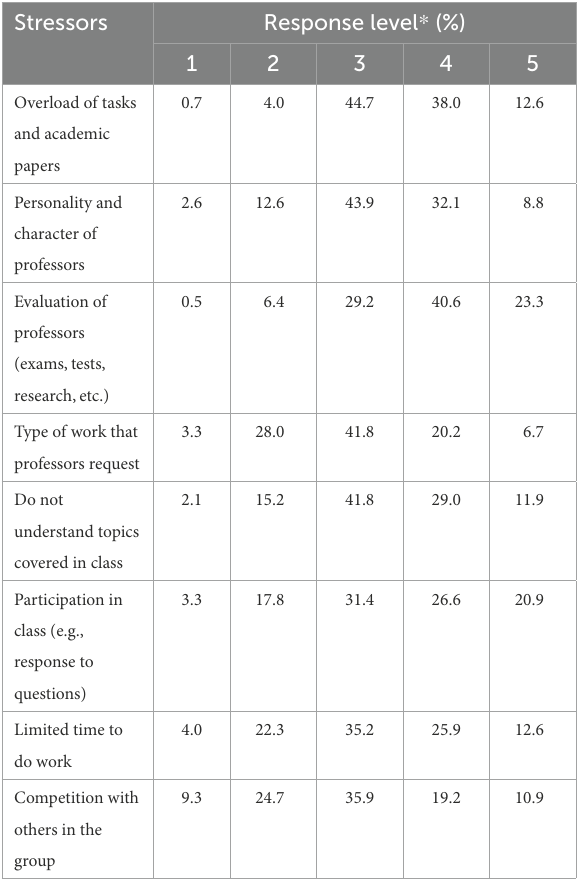
TABLE 3 Distribution of stressors by response level among medical students ( n =